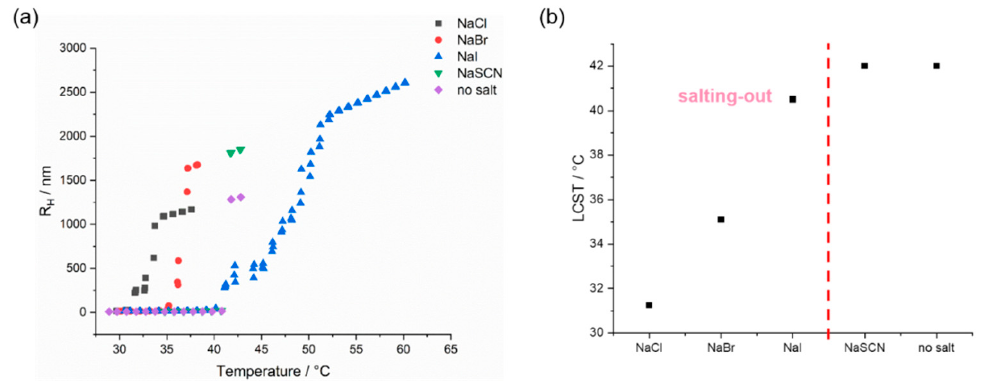
Figure 8. ( a ) The effect of anions on the hydrodynamic radii evolution of P(DMA 35 -NIPAM 212 ) 28 (c = 1% ( w / w )) as a function of temperature calculated by DLS measurements. ( b ) The impact of the anions on the LSCT of P(DMA 35 -NIPAM 212 ) 28 determined by DLS measurements. The concentration of the sodium salt solutions was 0.5 M in all measurements.